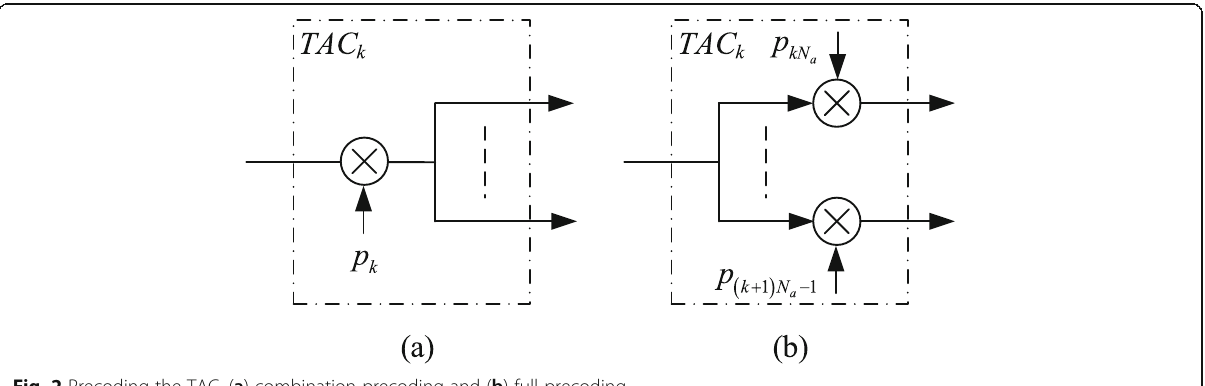
Fig. 2 Precoding the TAC, ( a ) combination precoding and ( b ) full